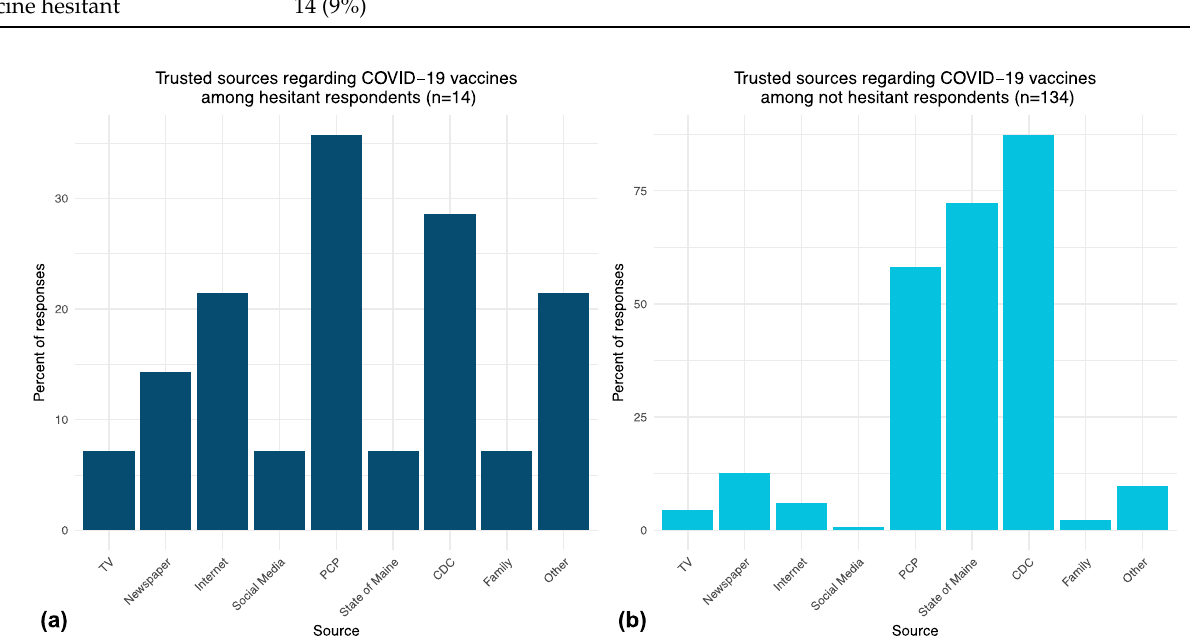
Figure 1. ( a ) Percentage of responses related to trusted sources of information about COVID-19 vaccines among hesitant respondents. ( b ) Trusted sources of information among not hesitant re- spondents.